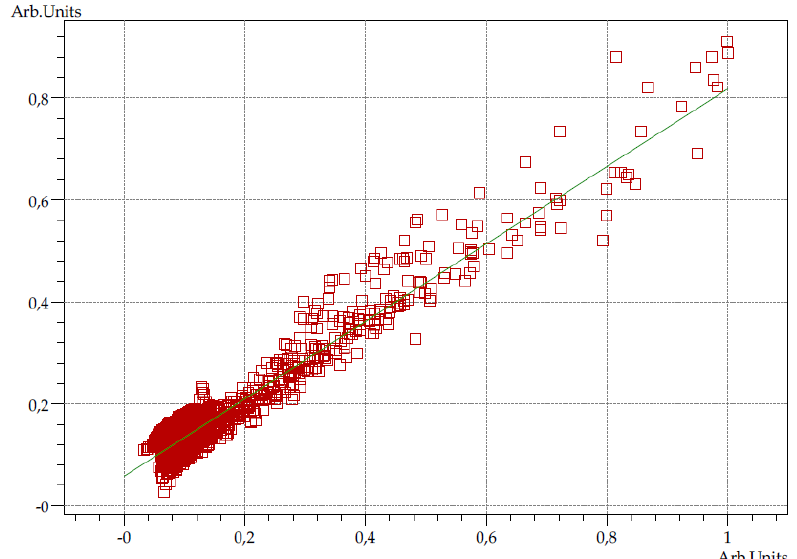
Figure 2. Correlation curve of the intensities of the precipitate spectrum and the reference spectrum.